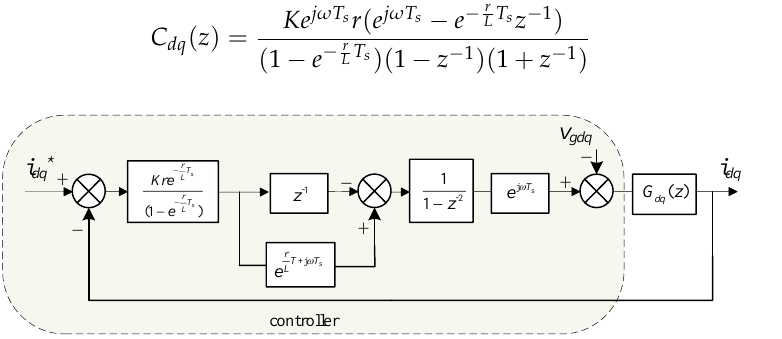
Figure 7. Complex vector block diagram of the inverter with the proposed control strategy, shown in the synchronous reference frame.